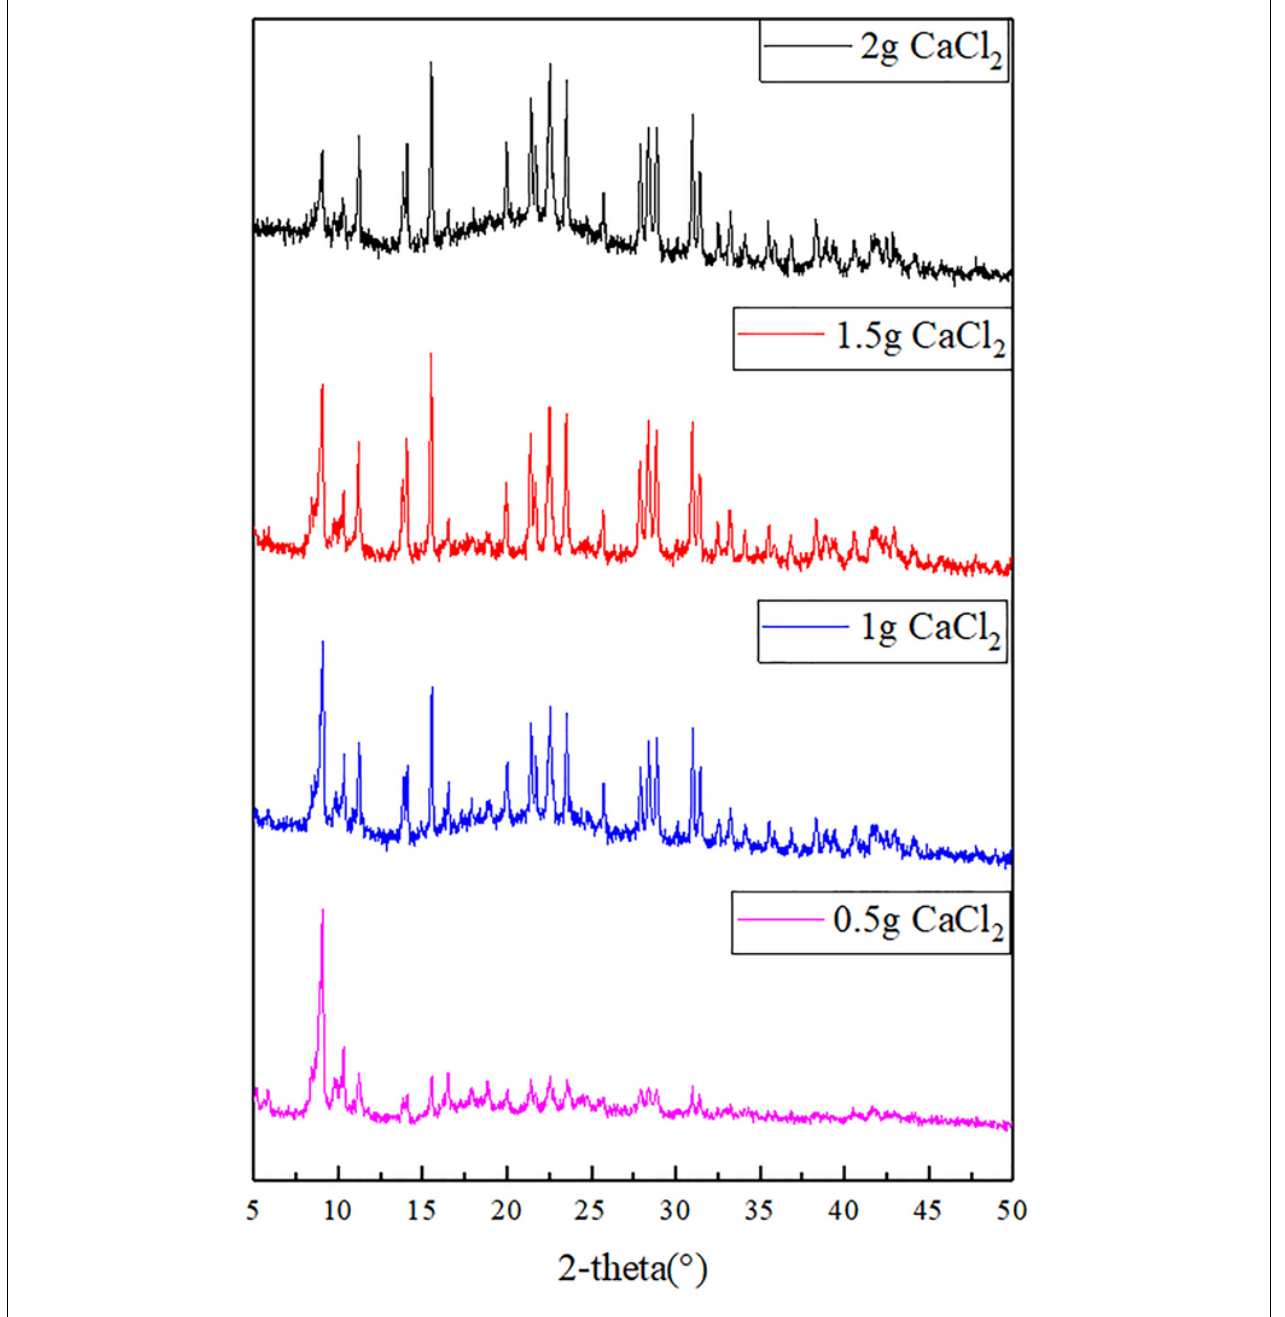
FIGURE 2 | XRD of mil-101 (Cr) after immersion in different concentration of salt